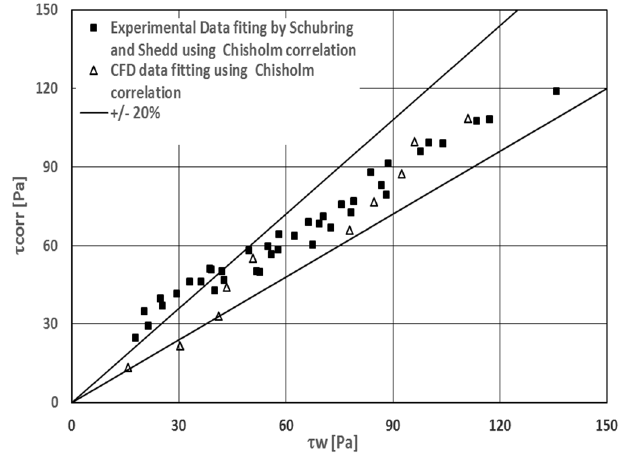
Figure 18. Comparison of the data fitting results for present CFD predictions and experimental measurements of Schubring and Shedd [10] using the Chisholm correlation. ( d i = 8.8 mm, u sl > 0.07 m/s).